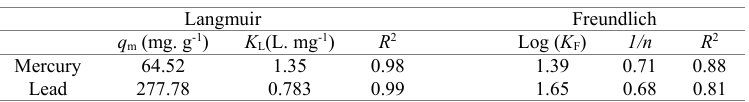
Fig. 7. (a) Langmuir isotherms for Hg 2+ adsorption onto NiO/ZSM-5. (b) Freundlich isotherms for Hg 2+ adsorption onto NiO/ZSM-5.